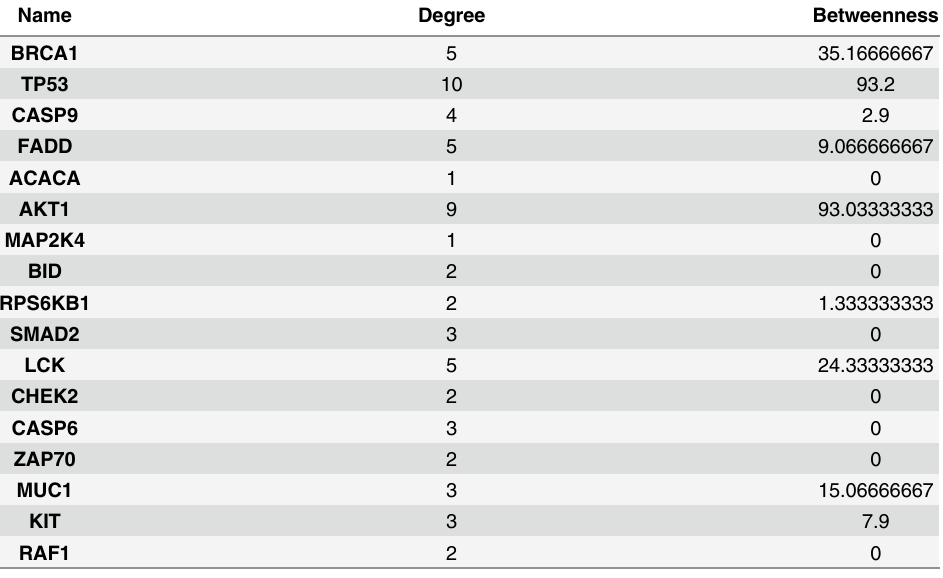
Table 7. Significantly enriched modular of down-regulated proteins using CentiScaPe